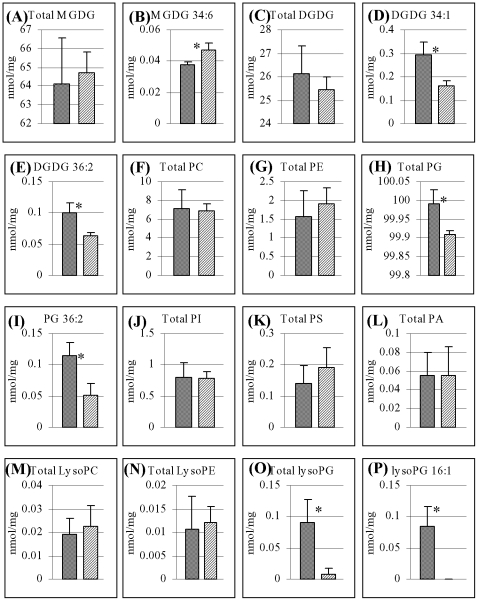
Differential lipid profiling between WT and oscyp96b4.(A) to (E) indicated the amount of total plant glycolipids MGDG and DGD and their specific molecular species. (F) to (K) showed the amount of total membrane phospholipids PC, PE, PG, PI and PS as well as their specific species. (L) to (P) showed the amount of total minor membrane lipid metabolites PA, lysoPC, lysoPE and lysoPG as well as their specific species. Only the molecular species with significant differences in their amount between WT and oscyp96b4 are presented. The symbol “*” indicates the significant differences between WT and the Ds insertion mutant by the t-test statistic analysis at P<0.05. In (A) to (P), left and right columns indicate WT and oscyp96b4, respectively.